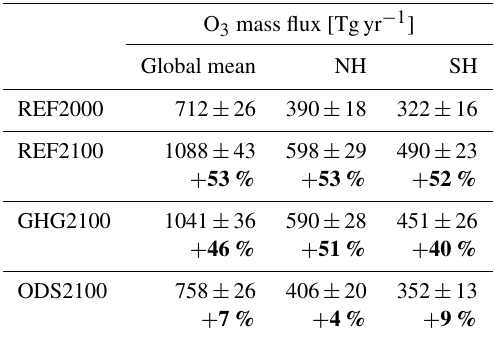
Table 2. Overview of the annual ozone mass flux into the tropo- sphere and the corresponding standard deviations in the EMAC time-slice simulations. Bold numbers indicate the change relative to the REF2000 simulation. All changes are significant at the 95% confidence